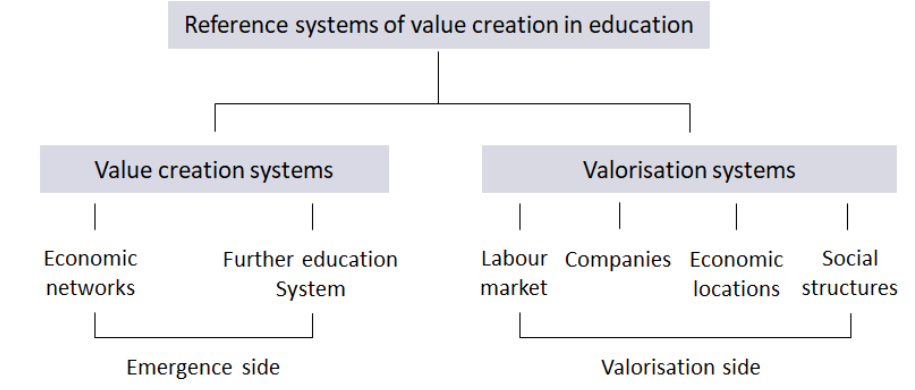
Figure 4. Reference systems of the emergence and valorisation of educational value (author’s own